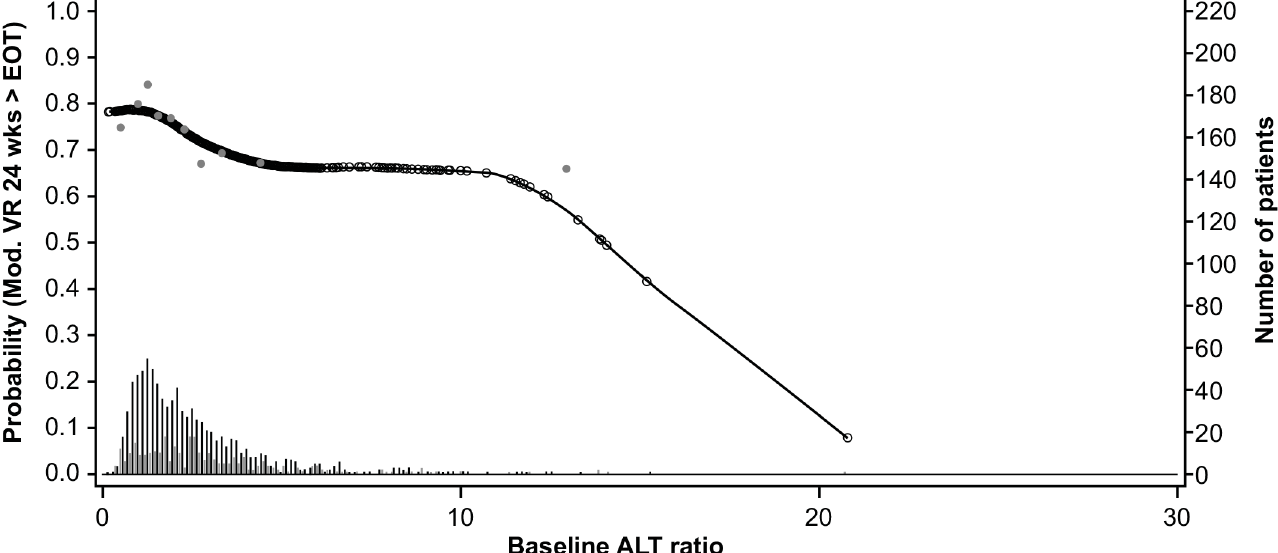
Fig 5. Relationship between alanine aminotransferase (ALT)/upper limit of normal (ULN) and sustained virologic response (SVR). Short vertical lines indicate the number of patients with SVR (black lines) and no SVR (grey lines). Open circles represent probability of SVR according to the GAM analysis. Closed circles represent empirical probability for midpoints of deciles. ALT/ULN = patients' ALT divided by the ULN for the local laboratory